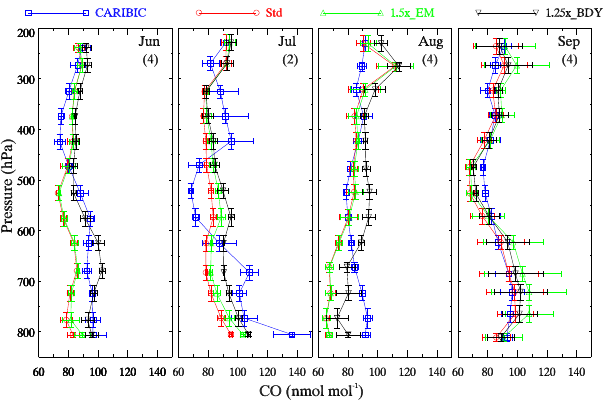
Figure 14. Sensitivity analysis of WRF-Chem simulated CO pro- files to the chemical boundary conditions. Standard CO profiles are compared with the simulation driven by 25% higher CO at the west- ern boundary of the domain as shown in Fig. 13. Results from 50% higher CO emissions over the whole domain (1 . 5 × _EM) are also shown for comparison. Numbers in brackets denote the number of observational profiles in the respective